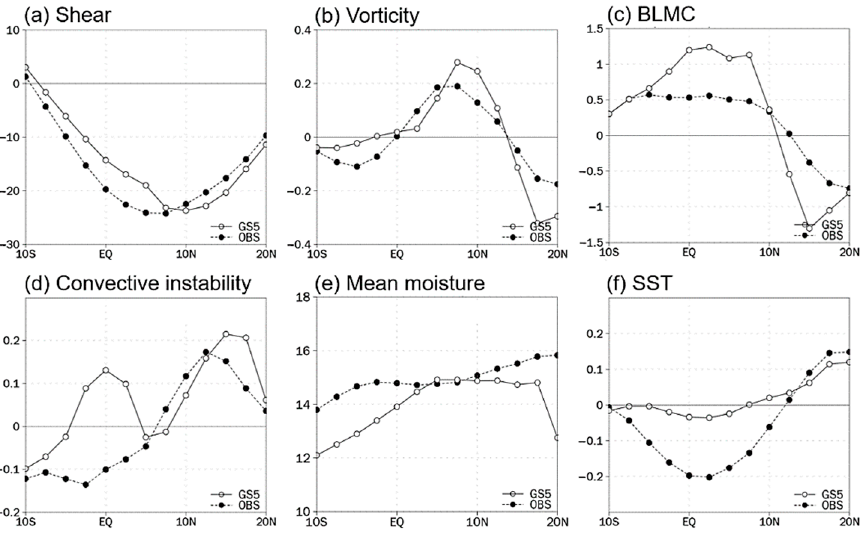
Figure 11. Meridional pattern of ( a ) mean state zonal shear (U200–U850; m s − 1 ) and ( e ) mean specific humidity (925 hPa) averaged over 80°–100°E from observation (dashed black with black mark) and the GS5 hindcast (solid black with blank mark) during boreal summer (May–November). The Meridional variation of regressed ISO ( b ) vorticity (s − 1 ) at 925 hPa, ( c ) boundary layer moisture convergence (day − 1 ) at 925 hPa, ( d ) convective instability (°C), and ( f ) SST (°C) averaged over 80°–100° E from observation and model simulations. We use the 20–70 day filtered precipitation anomaly averaged over 5° S–5° N and 80°–100° E as a reference for calculating ( b – d , f ).